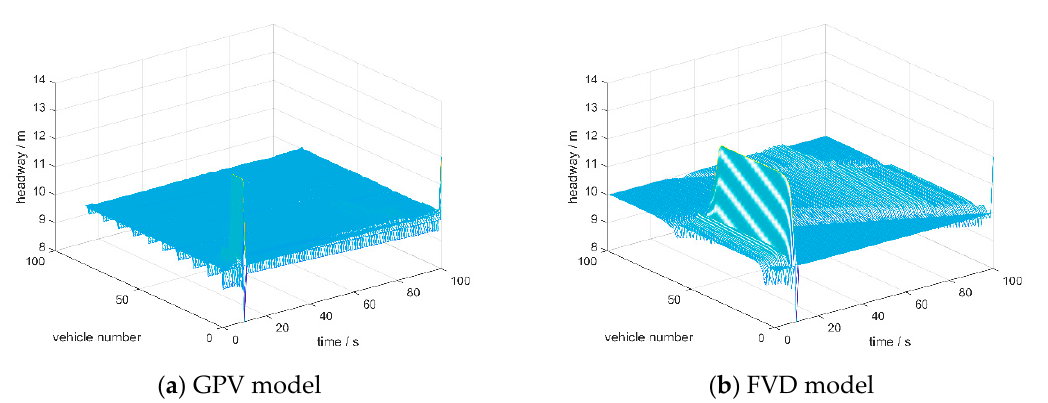
Figure 10. Propagation process of disturbance in the vehicle fleet with the two models.